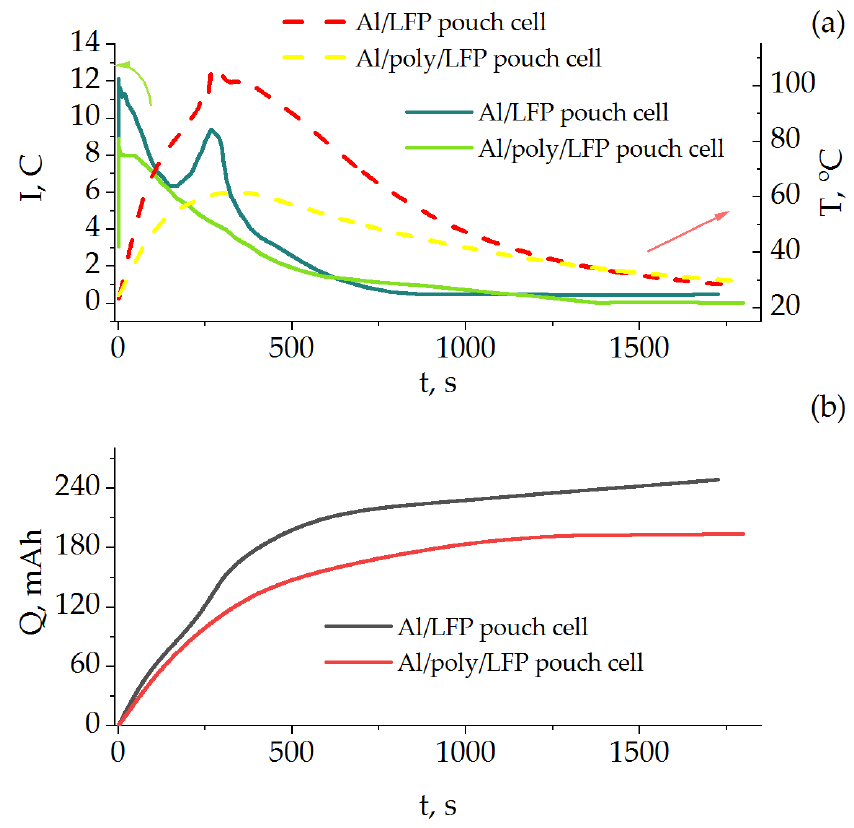
Figure 8. Time dependence of current (in C-rate units) and temperature ( a ); capacity ( b ) measured in the pouch cells’ short-circuit tests.